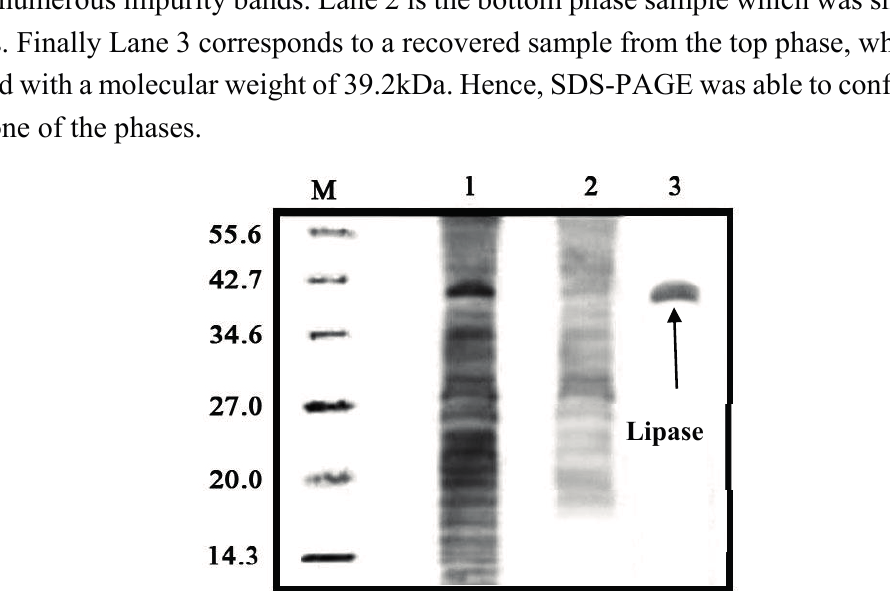
Figure 6 . SDS-PAGE analysis of the lipase recovery. The protein molecular weight of the standard protein markers ranged from 6.5 to 55.6 kDa. Lines: M = protein molecular markers; 1 = crude feedstock; 2 = ATPS top phase lane; 3 = ATPS bottom phase.